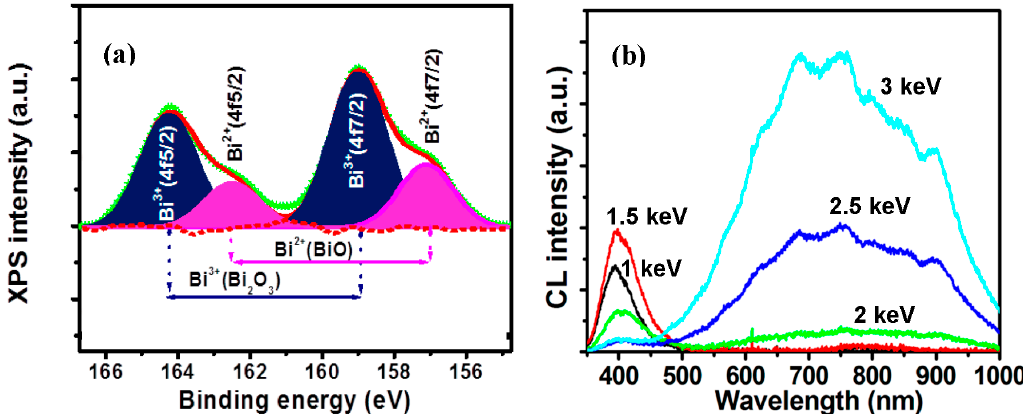
Figure 13. ( a ) Bi 4f high resolution deconvoluted XPS spectrum of a 1200 °C post-annealed CaO:Bi phosphor powder; and ( b ) CL spectra obtained at different beam voltages (1–3 keV) [48].